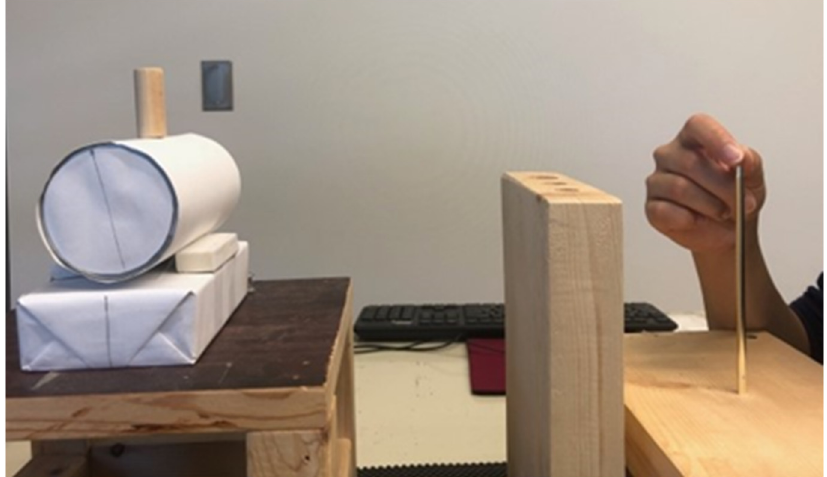
Figure 1. Experimental setup. Participants were seated in front of the apparatus in a fully lit envi- ronment. For the grasping task, they were asked to reach, grasp, and transport the cylinder as fast as possible. For the manual estimation task, they were asked to open the thumb and index finger to indicate the size of the cylinder.